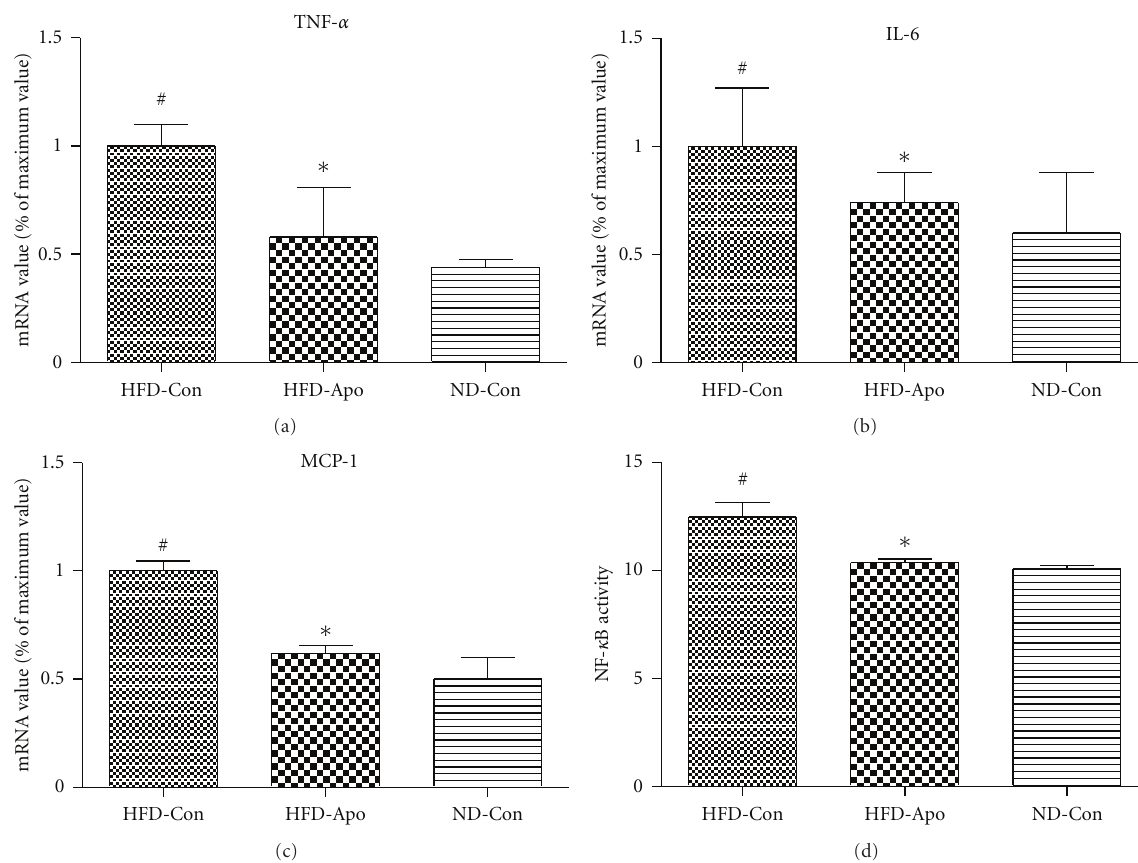
Figure 5: E ff ects of apocynin on inflammation-related genes expression and the activity of NF- κ B in the liver. Apocynin treatment decreased the gene expression of (a) TNF- α , (b) IL-6, (c) MCP-1 in HFD-Apo group compared to HFD-Con group. (d) Hepatic NF- κ B activity was tested by the special kit (Trans-AM NF- κ B kit). The hepatic NF- κ B activity is lower in the HFD-Apo group than that in the HFD-Con